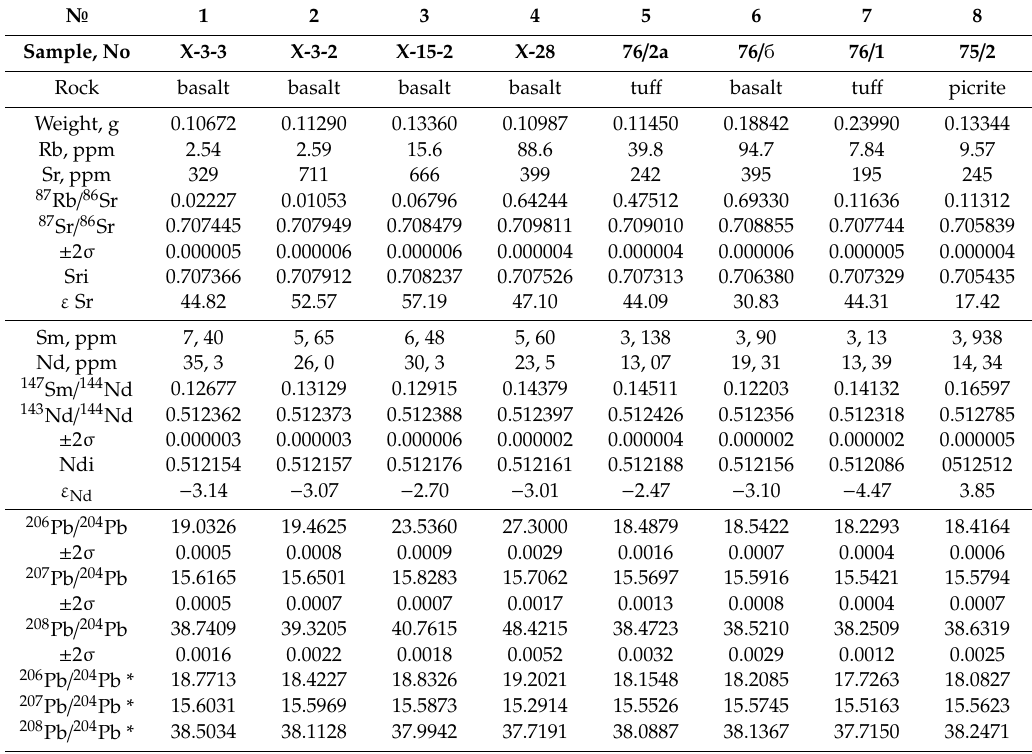
Table 3. Isotope composition of the the volcanic